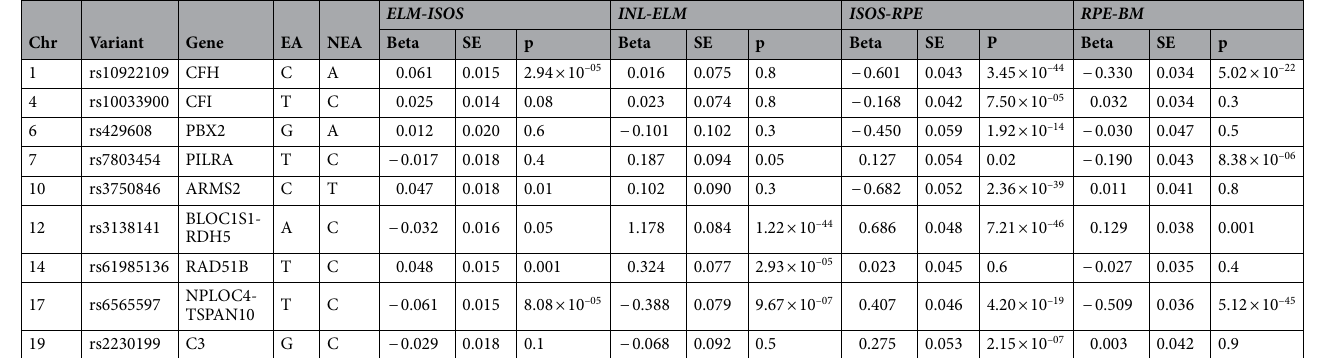
Table 2. Significant associations between central SD-OCT measurements and AMD variants. Columns “Variant”, “EA” and “NEA” list variants that were included in the model, and their risk alleles (EA, effect alleles for which the effect sizes are reported and NEA, non-effect alleles). Fields “Beta”, “SE” and “P” denote the change in SD-OCT measurements, standard errors and p-values of observed associations. The table includes significant linear regression results for 32,113 unrelated participants from UK Biobank participants. Models were adjusted for sex, age, spherical equivalent, smoking status.